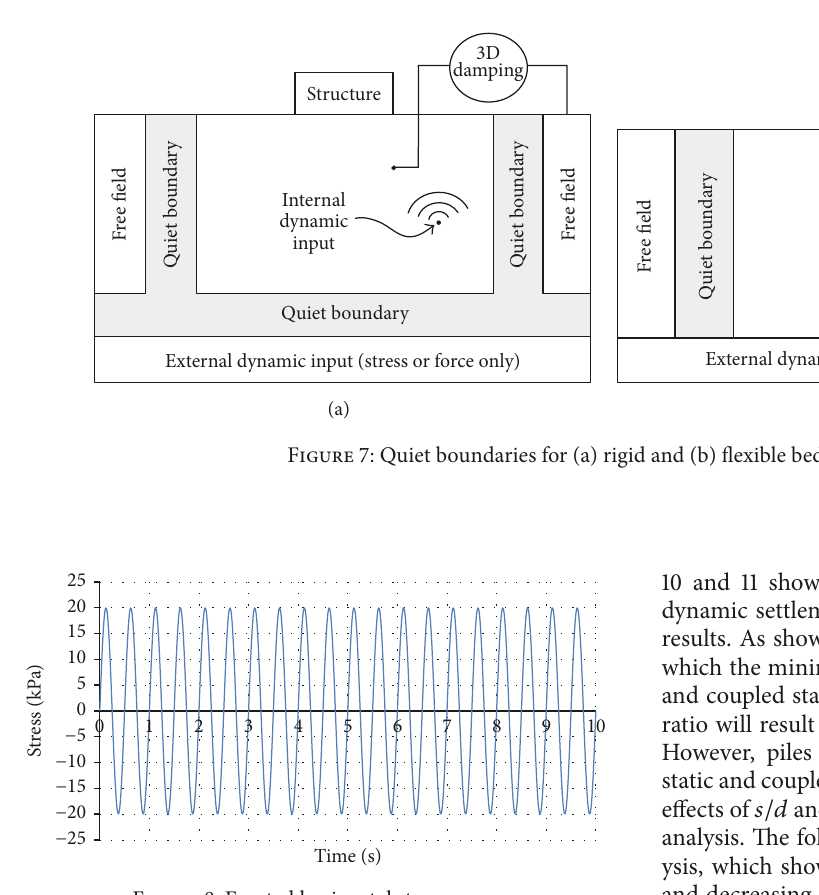
Figure 8: Exerted horizontal stress